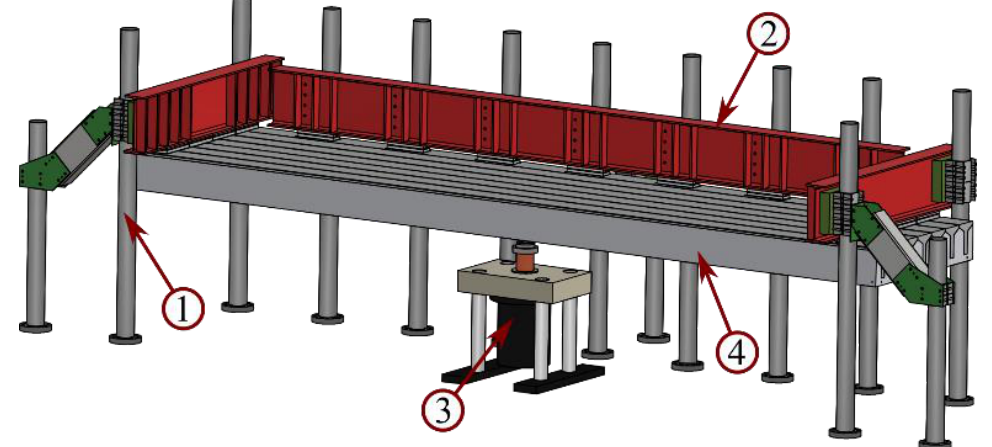
Figure 5. Laboratory test setup with ( 1 ) multiple load-carrying columns with three stiffeners, ( 2 ) horizontal I-profiles along three edges for support along with pinned bearings between the profiles and the slab surface, ( 3 ) the primary actuator used for load application and ( 4 ) the OT-slab.